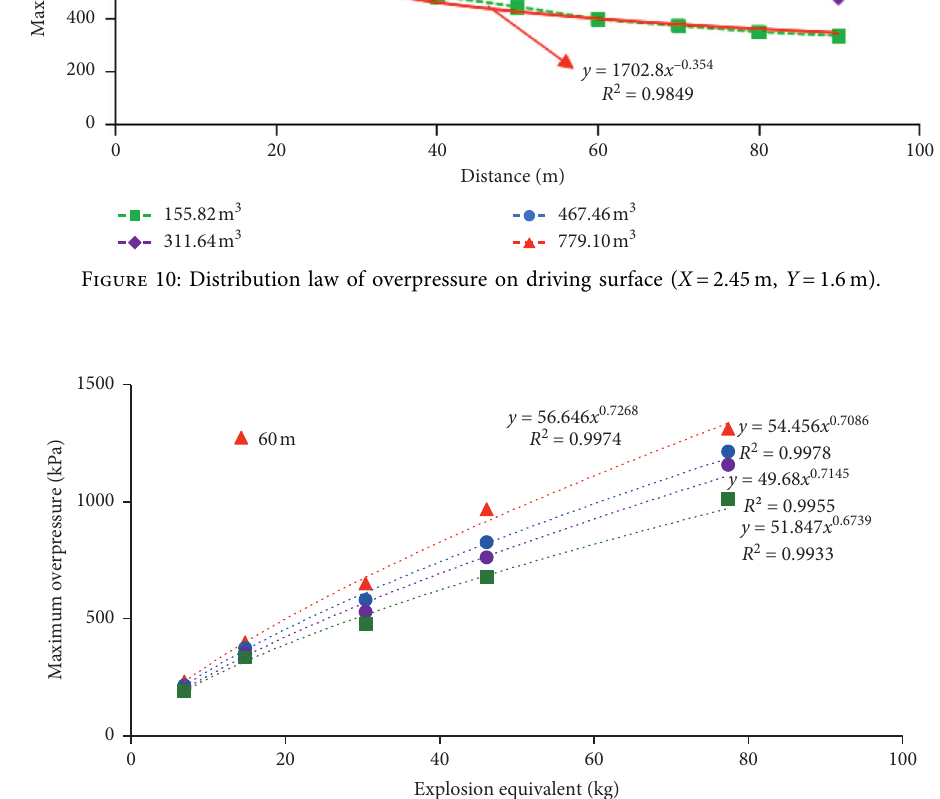
Figure 11: Relationship between overpressure peak and explosive equivalent at different positions in the heading